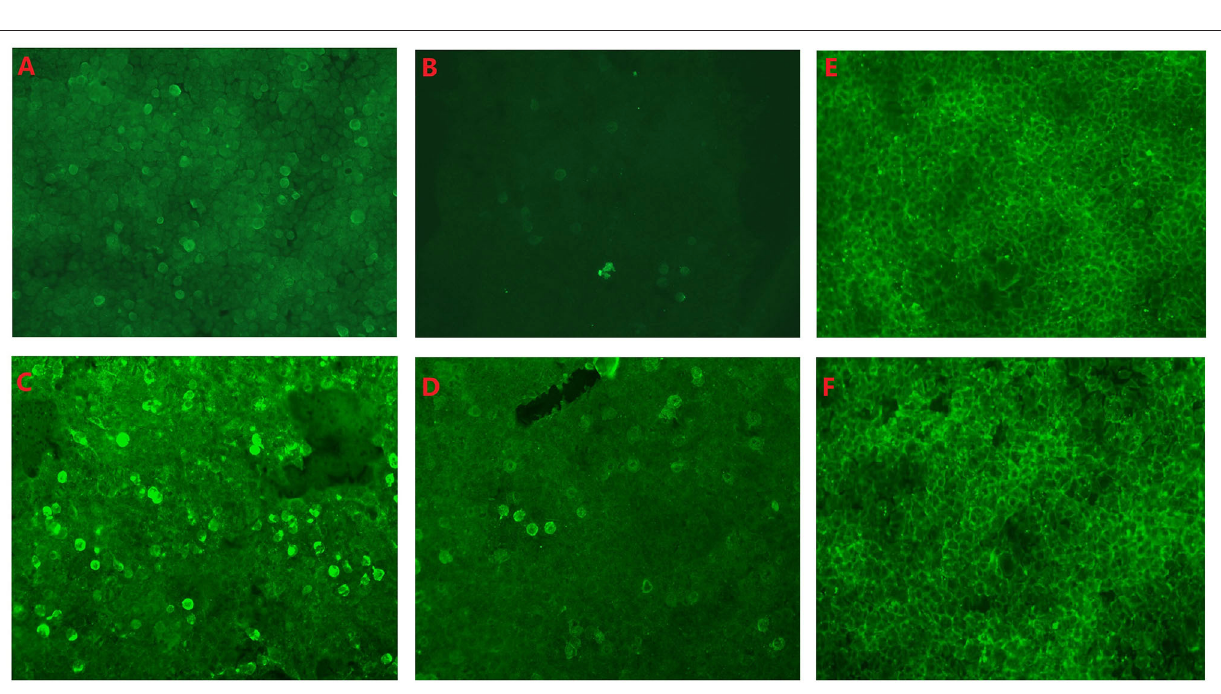
urinary symptoms, fluctuating hypothermia/hyperthermia, asymptomatic ventricular tachycardia, and cardiac arrest